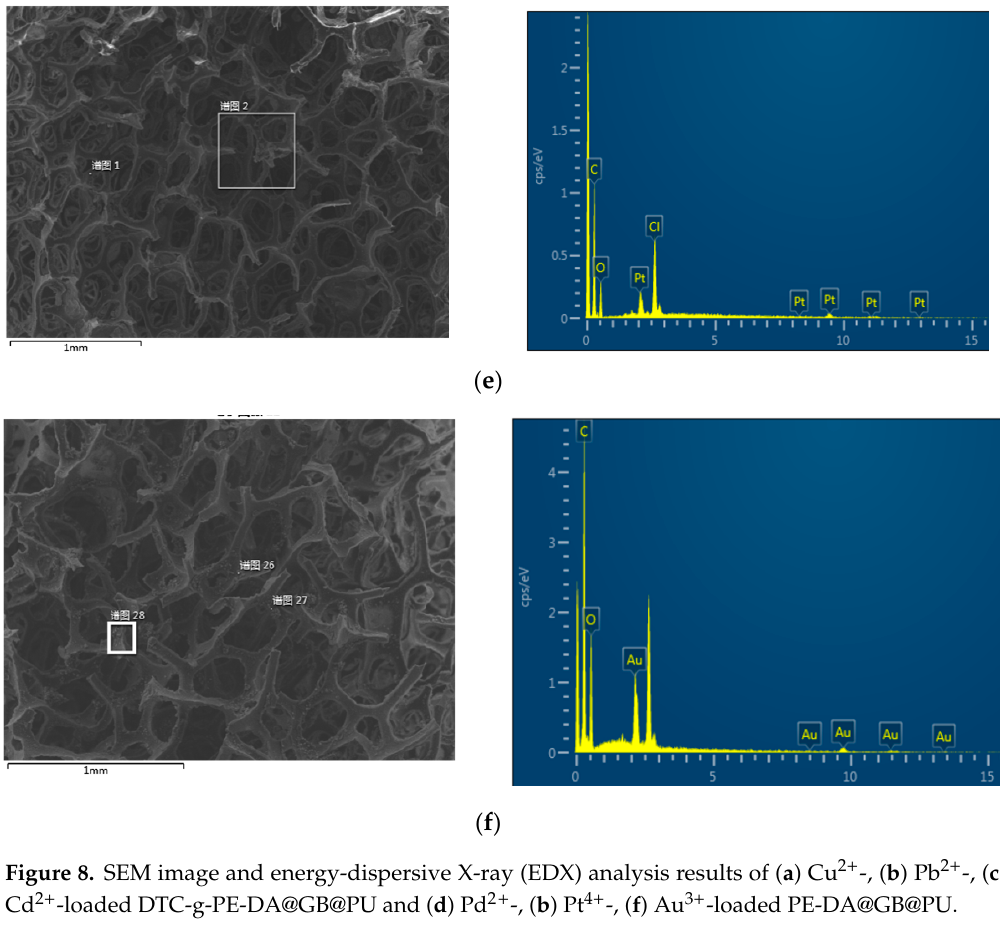
Figure 8. SEM image and energy-dispersive X-ray (EDX) analysis results of ( a ) Cu 2+ -, ( b ) Pb 2+ -, ( c ) Cd 2+ -loaded DTC-g-PE-DA@GB@PU and ( d ) Pd 2+ -, ( b ) Pt 4+ -, ( f ) Au 3+ -loaded PE-DA@GB@PU.